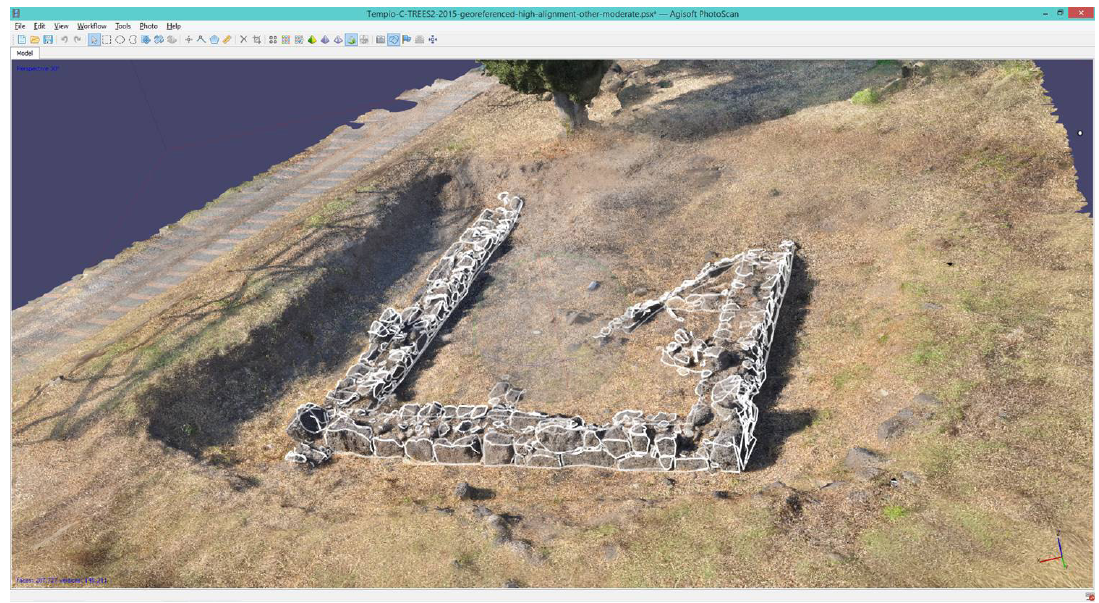
Figure 3. Eastern half of Tempietto C. Textured photogrammetry model with 3D total station survey of blocks (Jari